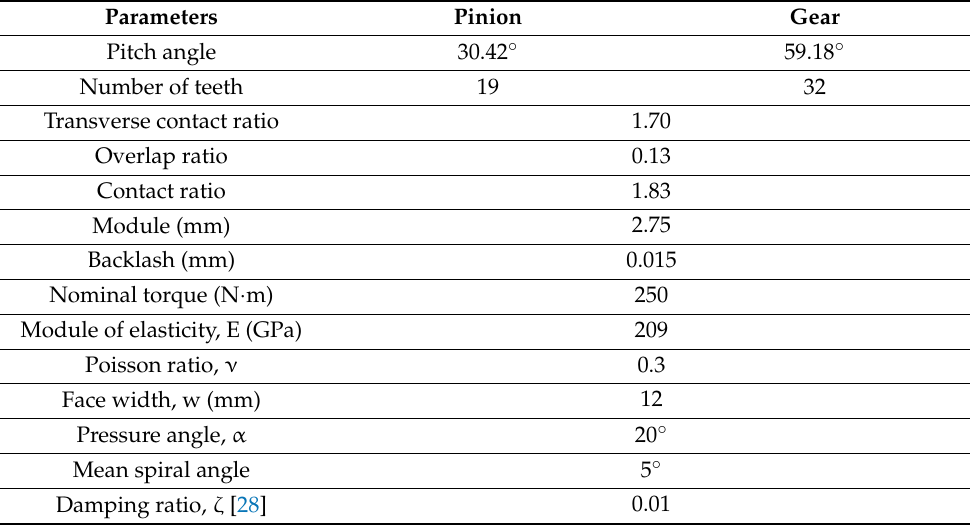
Table 2. Geometric parameters of the SBG